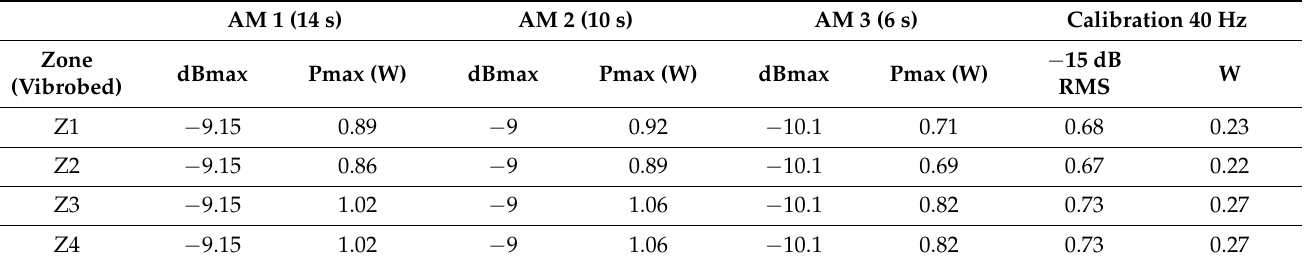
Figure A1. Visualisation of Amplitude Modulation used by Vibrobed. Table A1. Parameters of audio-recording for